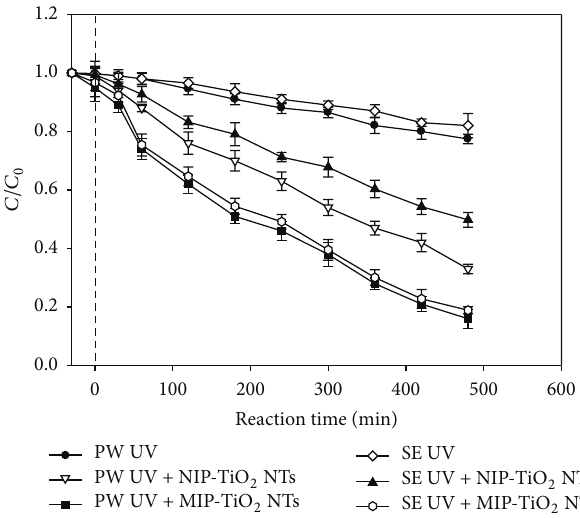
Figure 9: PFOA degradation in secondary effluent (SE) and pure water (PW). PFOA concentration added in SE was the same as that in PW. Initial solution concentration 𝐶 0 and pH are 30 mg/L and 5,